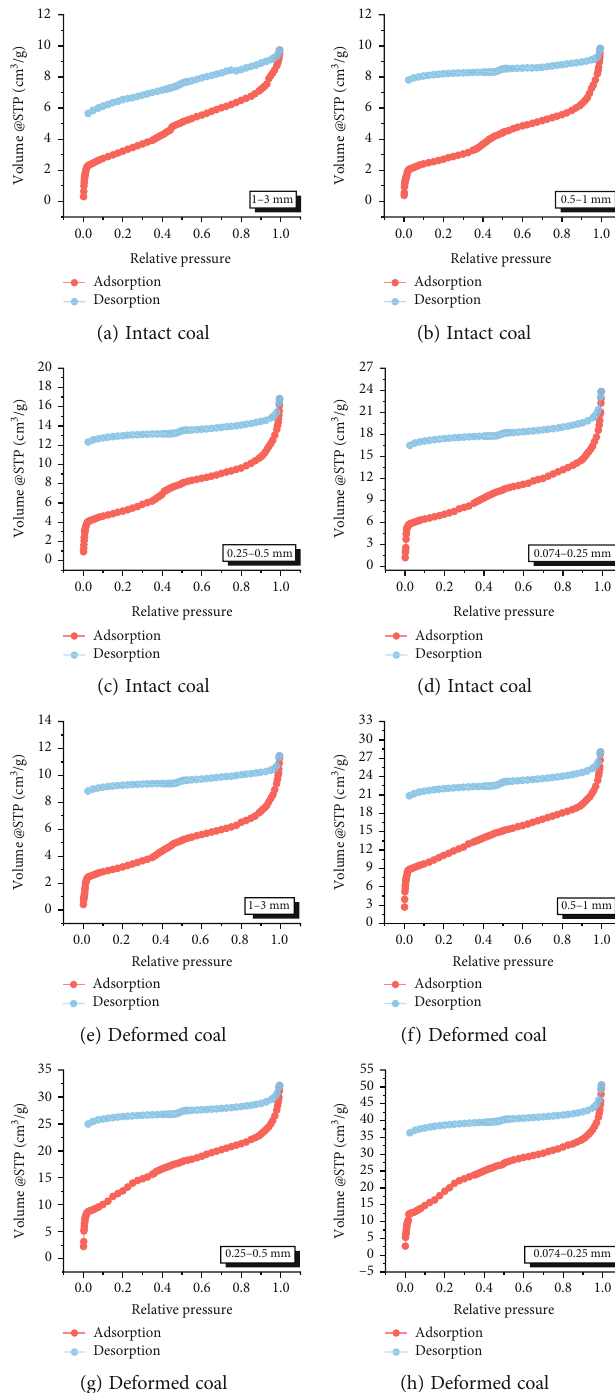
adsorption and desorption 2